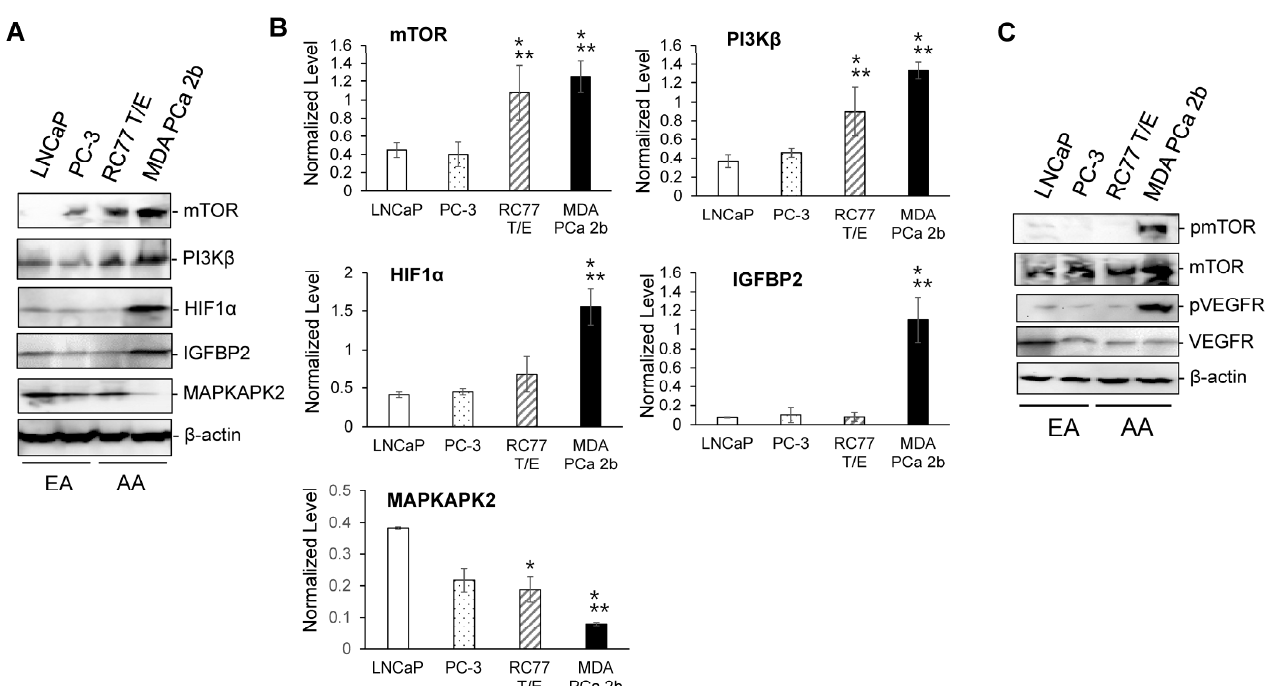
Figure 2. Western blot analysis of mTOR, PI3K β , HIF1 α , IGFBP2 and MAPKAPK2 in AA and EA PCa cell line models. ( A ) Representative Western blot images of mTOR, PI3K β , HIF1 α , IGFBP2, MAPKAPK2 and β -actin in EA PCa (LNCaP, PC-3) and AA PCa (RC77 T/E and MDA PCa 2b) cell lines. ( B ) Normalized protein levels of mTOR, PI3K β , HIF1 α , IGFBP2 and MAPKAPK2 in EA PCa and AA PCa cell line models. The normalized protein level was measured by dividing intensity of the tested protein (mTOR, PI3K β , HIF1 α , IGFBP2 or MAPKAPK2) with intensity of endogenous protein β -actin. Data were presented as mean ± SD of n = 3–4 independent immunoblot experiments, and the significance (* p < 0.05 in AA PCa cell line vs. LNCaP, and ** p < 0.05 in AA PCa vs. PC-3) was determined based on ANOVA with Tukey post hoc test. ( C ) Phosphorylation states of mTOR and VEGF in EA PCa (LNCaP and PC-3) and AA PCa (RC77 T/E and MDA PCa 2b) cell models. The pmTOR/mTOR and pVEGFR/VEGFR ratios were significantly higher in MDA PCa 2b (a metastatic AA PCa line) than in other three cell lines.